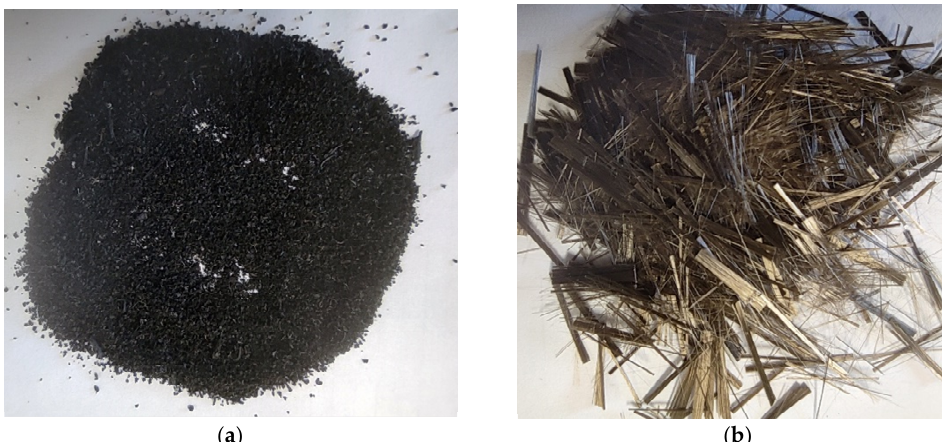
Figure 1. Physical appearance of the materials used. Powdered rubber ( a ) and carbon fibers ( b ).